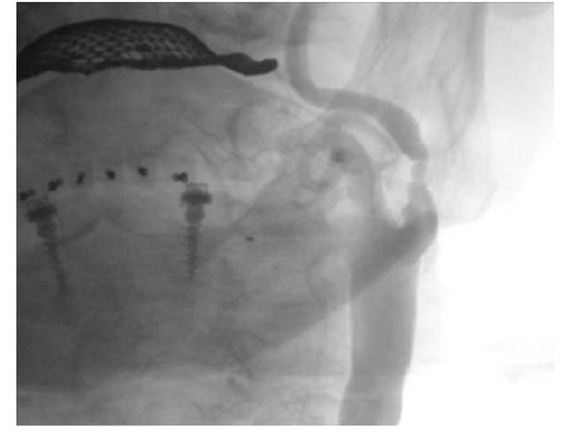
Figure 1. Conventional angiography of the left internal carotid artery with a severe stenosis by an 80 years old male patient.